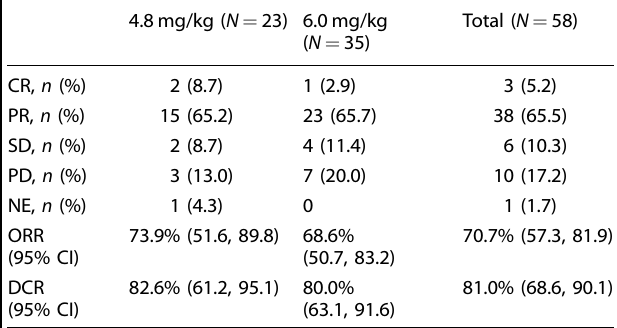
Fig. 1 Pharmacokinetic pro fi le of A166. a A166 concentration – time curve in each dose group. b A166 and Duo-5 concentration – time curves in the 4.8 and 6.0 mg/kg dose groups. The green dotted line indicates the mean C max of T-DXd ADC and free payload in the 5.4 mg/ kg dose group, and the blue solid line indicates the mean C max of T-DM1 ADC and free payload in the 3.6 mg/kg dose group. Error bars indicate standard deviation (SD). Duo-5 = Duostatin-5 (anti-microtubule agent, payload of Table 3. Best responses for HER2-positive breast cancer patients in 4.8 and 6.0 mg/kg cohorts.